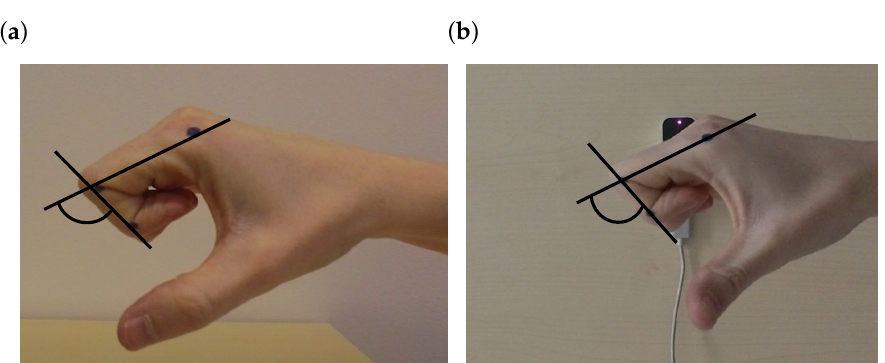
Figure 9. View of the camera on the index finger to track the movement. Black points at the joints of the index finger were tracked by the video tracking software Tracker [31]. With the positions from the tracking software the proximal interphalangeal joint angles (flexion, φ PP , IP ) could be calculated. ( a ) Camera on left side of the sensor. ( b ) Camera above the